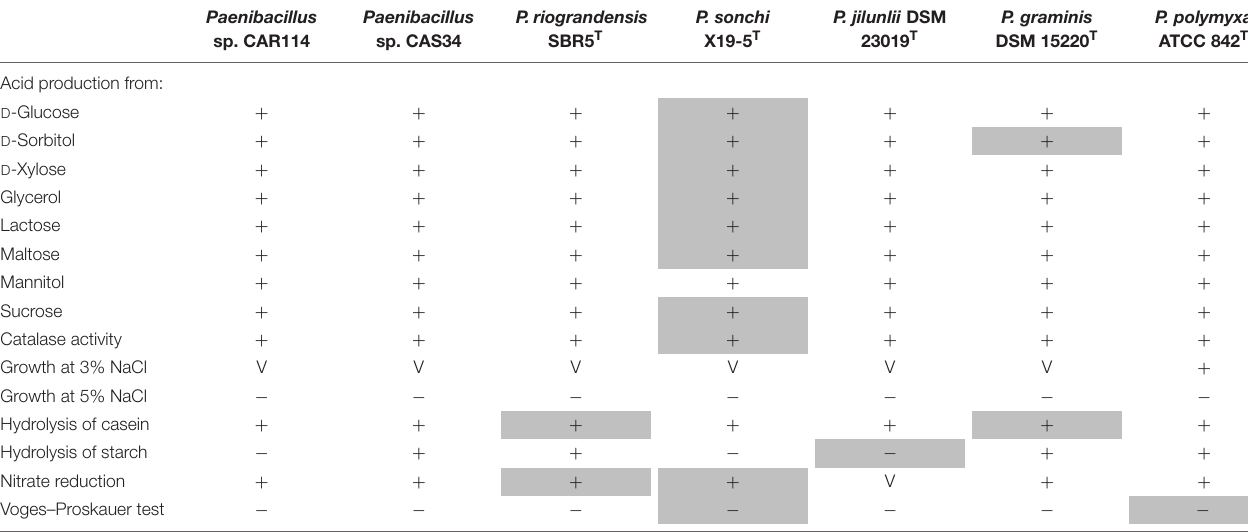
TABLE 1 | Comparison of biochemical characteristics of Paenibacillus